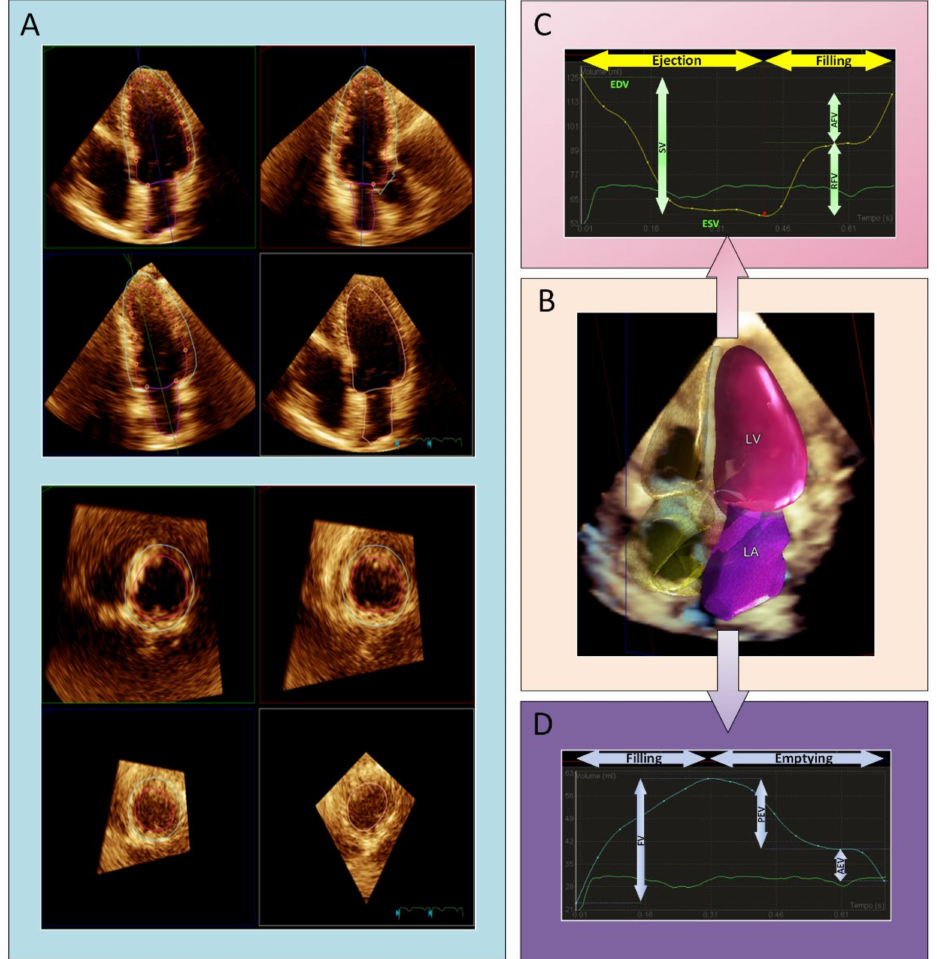
Figure 1. ( A ) DHM automated analysis of left ventricular and left atrial volumes in apical view. ( B ) 3D surface rendering of the LV (pink and semitransparent blue) and LA (purple) at end-diastole. ( C ) Analysis of LV volume–time curves, resulting in dynamic ejection and filling, end-diastolic (EDV) and end-systolic volumes (ESV), stroke volume (SV), rapid filling volume (RFV), and atrial filling volume (AFV). ( D ) Analysis of LA volume–time curves, resulting in dynamic filling and emptying: filling volume (FV), passive emptying volume (PEV), and active emptying volume (AEV). LA = left atrium; LV = left